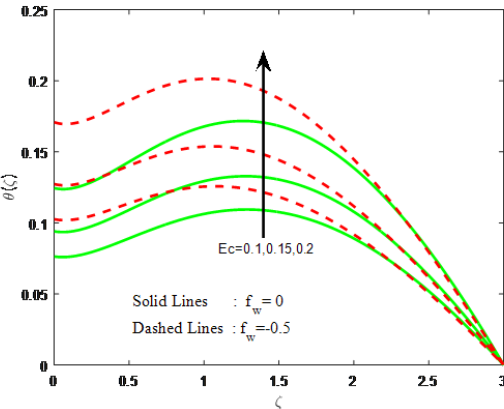
Fig. 11: The effect of power law of index n on temperature field pro- file